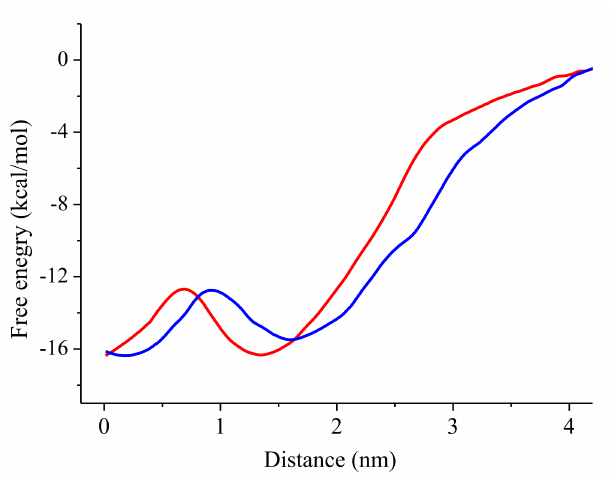
Figure 5. PMF for the insertion of wild uperin (blue line) and its alanine mutant (red line) into the POPG/POPE